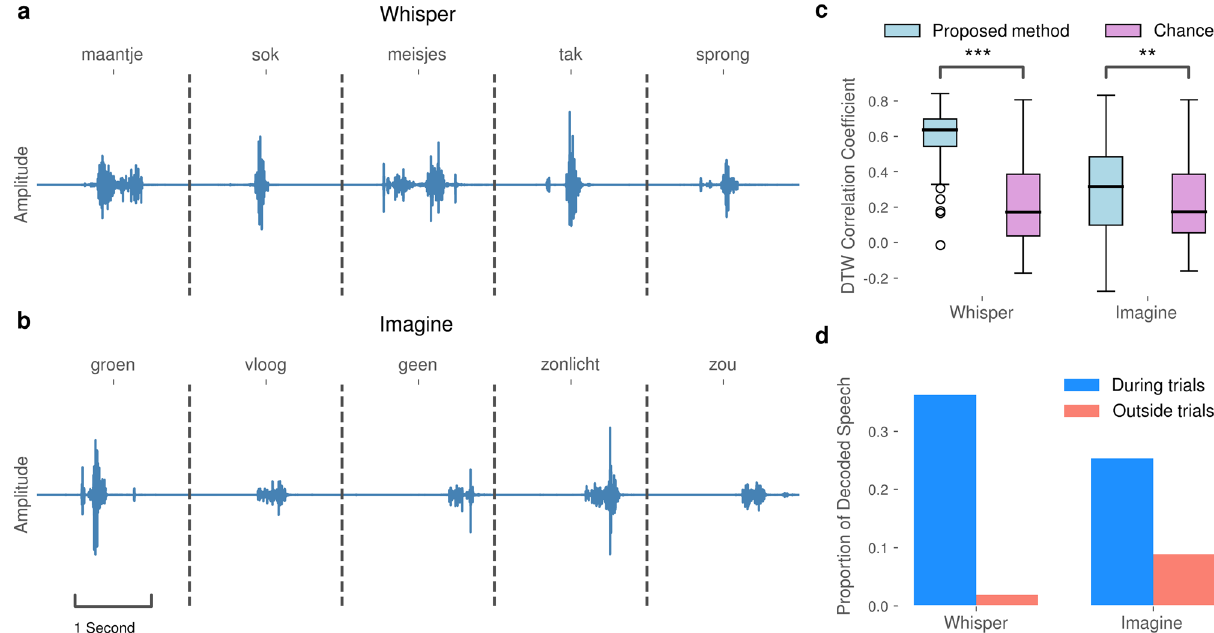
Fig. 4 Decoding results of the proposed method in the closed-loop experimental runs. a Selected examples of synthesized audio waveforms produced during whispered speech trials. b Selected examples of synthesized audio waveforms produced during imagined speech trials. In both runs, the speech was reliably produced when the participant was prompted to whisper or imagine to speak, respectively. c Pearson correlation coef fi cients between time-warped reference speech trials and closed-loop whispered trials ( n 1 = 73) and closed-loop imagined speech trials ( n 1 = 75), respectively. Chance level ( n 2 = 1000) is based on randomly selected data from non-speech tasks performed by the participant. Statistical signi fi cance, indicated by asterisks (*** P < 0.001; ** P < 0.01), was computed using Mann – Whitney U tests. Black horizontal lines correspond to median DTW correlations scores. Boxes de fi ne boundaries between the fi rst and the third quartile. Error bars present the range of data within 1.5 times the interquartile range, and points beyond the range of the error bars show outliers. d The proportion of decoded and synthesized speech during whispered and imagined trials, respectively, versus non-speech intertrial